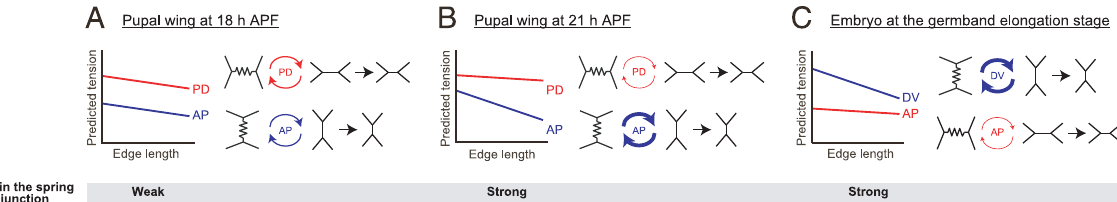
Fig 7. Summary of the results of parameter estimation. (A–C) Schematics showing the results of parameter estimation in the pupal wing at 18 h APF (A), in the pupal wing at 21 h APF (B), and in the embryo at the GBE stage (C). Line color represents junctions along the specific axis of the tissue and the arrow width represents the magnitude of the feedback. The results of parameter estimation indicated that the positive feedback between junction tension and shrinkage is strengthened at remodeling junctions during passive cell rearrangement in the pupal wing (B) and active cell rearrangement in the embryo (C) but not active cell rearrangement in the pupal wing